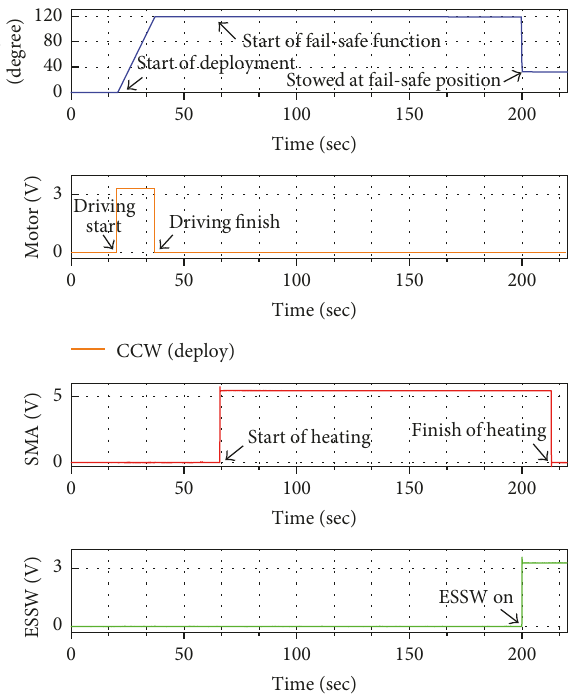
Figure 8: Time histories obtained from the fail-safe function test by using SMA spring